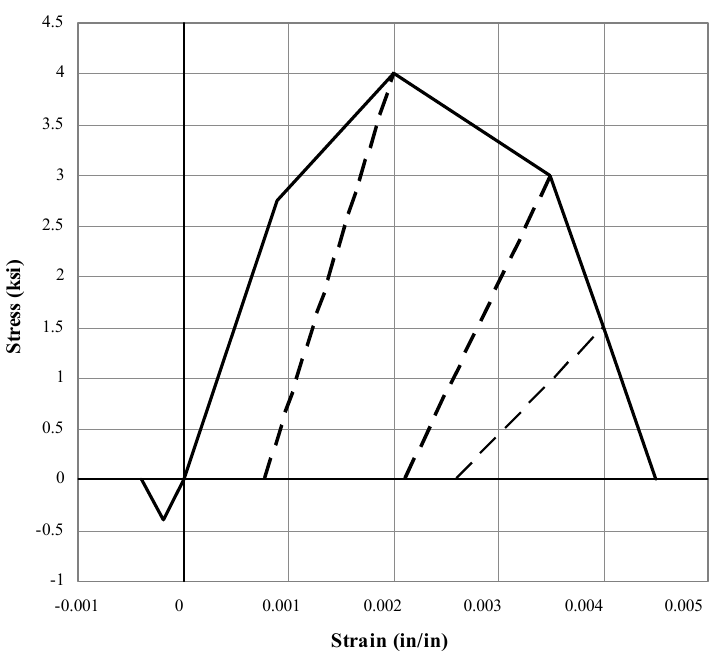
Fig. 18. Slab concrete material